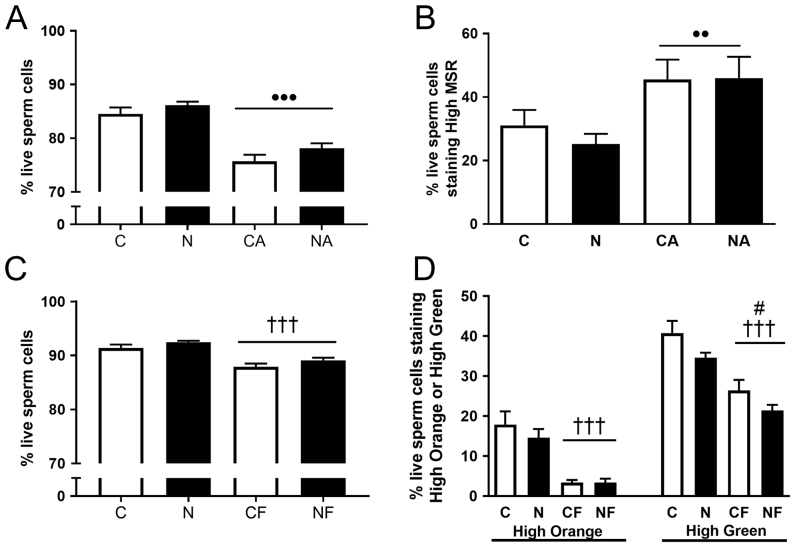
Viability, oxidative stress and mitochondrial membrane potential of sperm from control and NMN-treated mice in the Oral Administration Cohort. (A) Viability as determined by 7-AAD staining of sperm used for oxidative stress measurement. ••
P ≤ 0.01 reduction in viability due to positive control AA. (B) Oxidative stress as determined by mitosox red (MSR) staining. •••
P ≤ 0.001 increase in oxidative stress due to positive control arachidonic acid (AA). (C) Viability as determined by 7-AAD staining of sperm used for mitochondrial membrane potential measurement. †††
P ≤ 0.001 reduction in viability due to positive control FCCP. (D) Mitochondrial membrane potential as determined by JC-1 staining. †††
P ≤ 0.001 reduction in HO and high green-staining sperm due to positive control FCCP. #
P ≤ 0.05 reduction in high green-staining sperm due to NMN. C, Control mouse sperm; N, NMN mouse sperm; CA, control mouse sperm treated with AA; NA, NMN mouse sperm treated with AA; CF, control mouse sperm treated with FCCP; NF, NMN mouse sperm treated with FCCP. Data are shown as mean ± s.e.m., n = 10–13 per group. Black bars are NMN-treated groups. Data were analysed using two-way ANOVA. Note Fig. 3A and B are measurements from the same sperm aliquot. Figure 3C and D are measurements of a different sperm aliquot, but from the same mice as for Fig. 3A and B. Data are mean ± s.e.m.